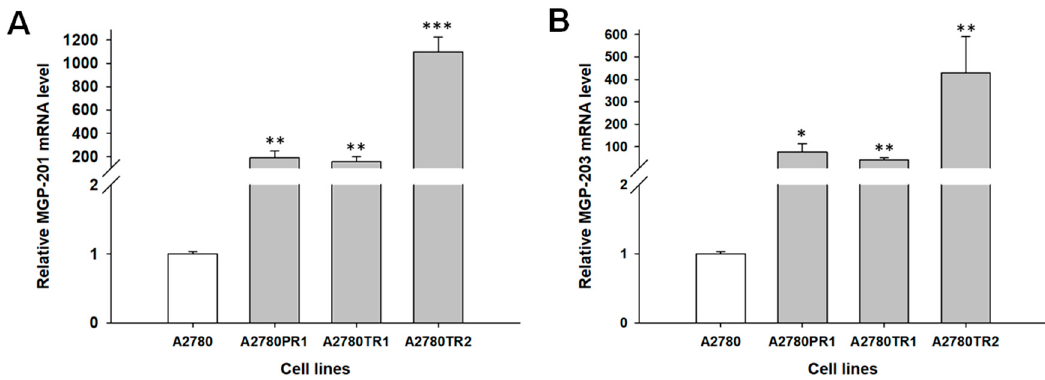
Figure 1. Expression analysis (Q-PCR) of the MGP1-201 ( A ) and MGP-203 ( B ) transcripts in the A2780 and drug resistant sublines. The figure presents the relative gene expression in the resistant cell lines (grey bars) with respect to that in the sensitive cell line (white bars), which was assigned a value of 1. The values were considered significant at * p < 0.05, ** p < 0.01 and *** p < 0.001.